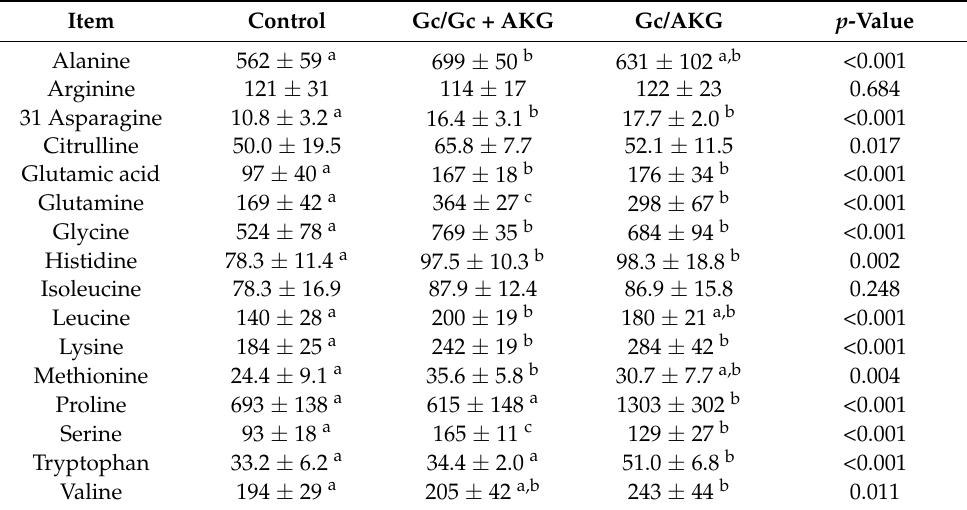
Table 4. Free amino acid concentrations (nmol/mL) in the blood serum of 35-day-old piglets.